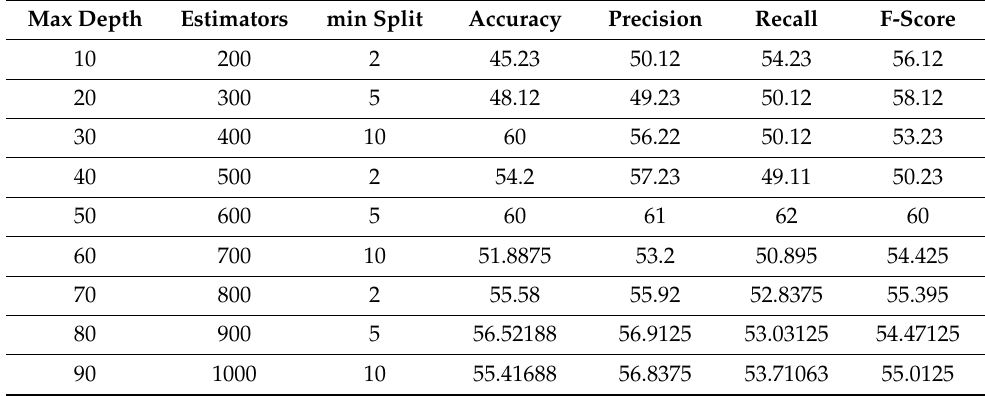
Table 2. Random forest hyperparameter